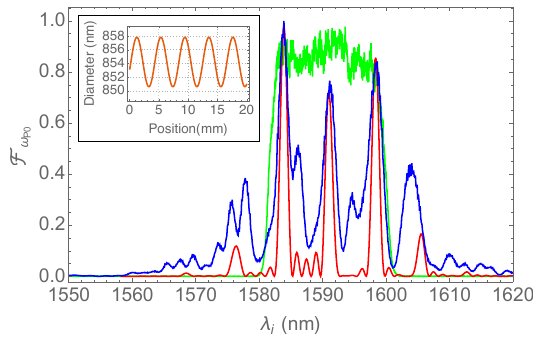
Fig. 2. Plot of the emitted spectrum at energy conservation at a pressure of 5 Bar (Blue curve), with the theoretical calculation (Red curve) for a nanofiber presenting a sinusoidal fluctuation of its diameter (shown in the insert). The pressure has been chosen so that all the main peaks, and thus most of the emitted idler photons, are inside the transmission band of the 1590nm channel of our Coarse WDM filter (Green curve).